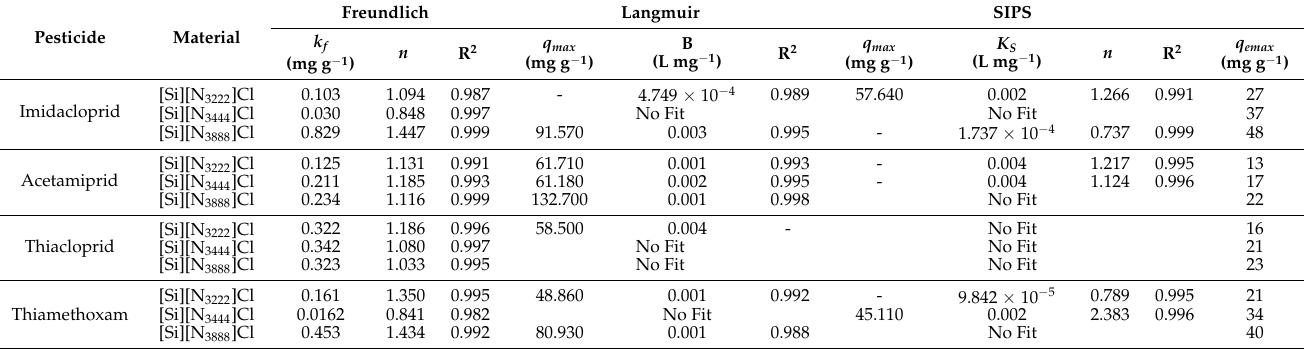
Table 4. Adsorption parameters obtained from the fit of adsorption isotherms experimental data isotherms with the Freundlich, Langmuir, and SIPs models, and the respective correlation coefficients for imidacloprid, acetamiprid, thiacloprid, and thiamethoxam with [Si][N 3222 ]Cl, [Si][N 3444 ]Cl, and [Si][N 3888